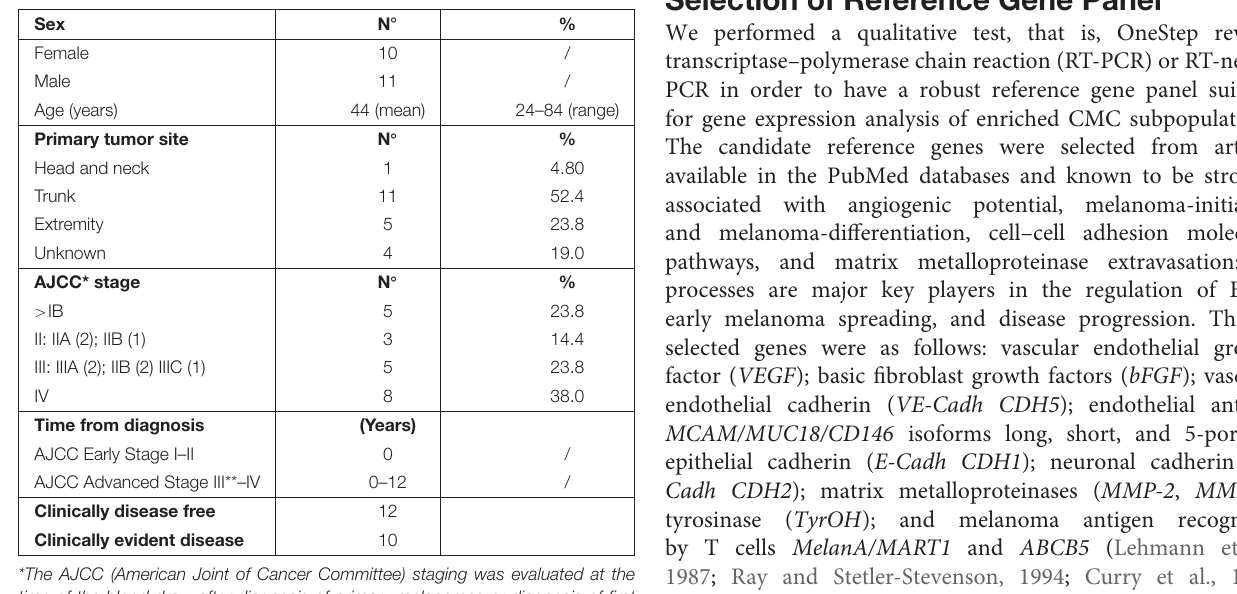
TABLE 1 | Patients’ (pts) demographic and clinical